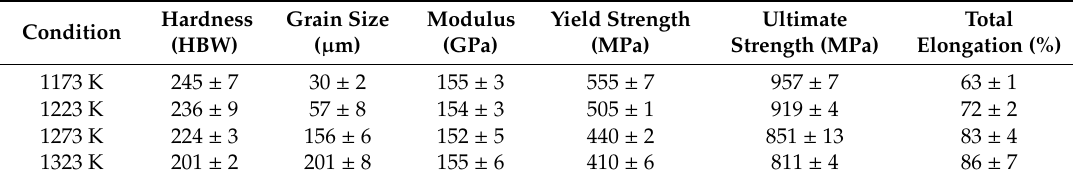
Figure 7. EBSD-OIM maps of the tensile tested alloy solution treated for two hours at ( a ) 1223 K (950